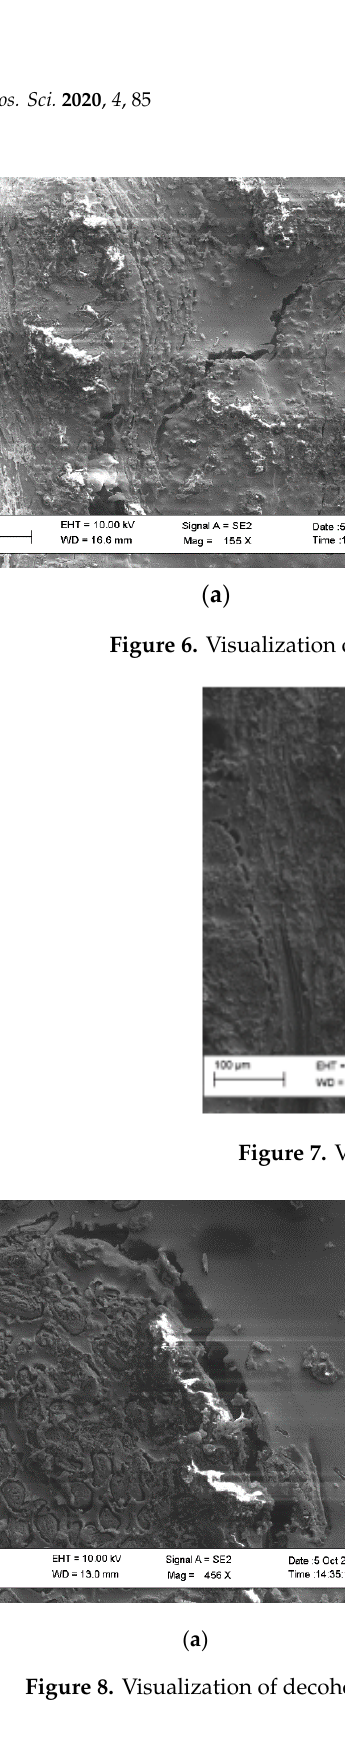
Figure 9. Visualization of delamination. Figure 10. Visualization of the breaking of the outer folds. 3.5. Acoustic Emission Results 3.5.1. Classification Methodology The k-means supervised classification method was used in order to segment data into different classes of signals. Five main temporal classifiers were selected for this treatment: - the amplitude;